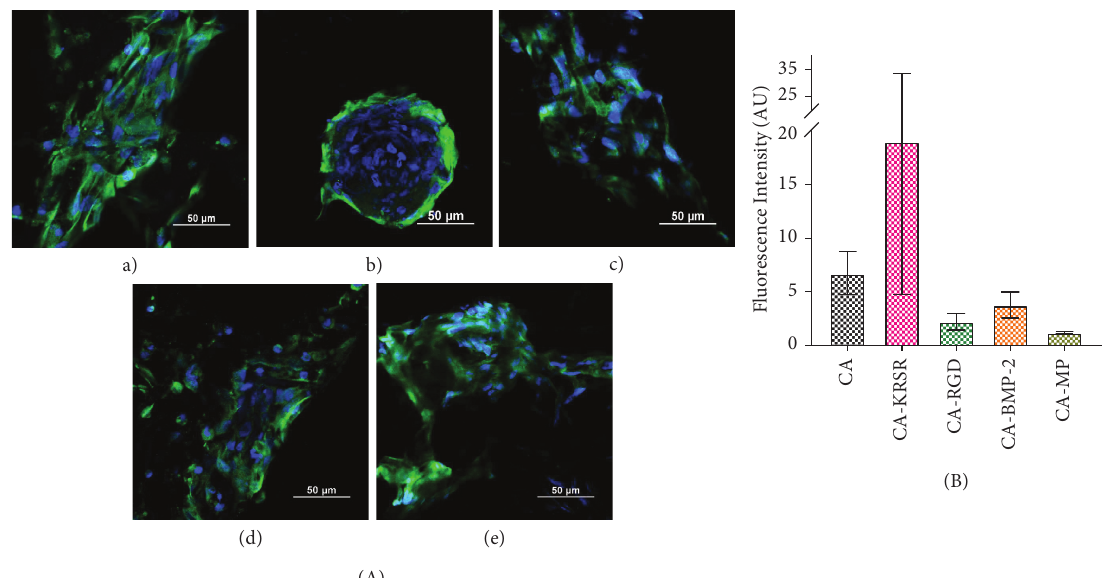
Figure 7: (a) Bone sialoprotein (green) assay for hFOB 1.19 (blue nuclei) across each CA electrospun mats. (A) CA Fiber mat, (B) CA-KRSR, (C) CA-RGD, (D) CA-BMP-2, and (E) CA-MP. Scale bar represents 50 µ m. (b) Alexa Fluor 488 Fluorescence Intensity plot for BSP expression normalized by the total cells. Error bars represent the standard error of the